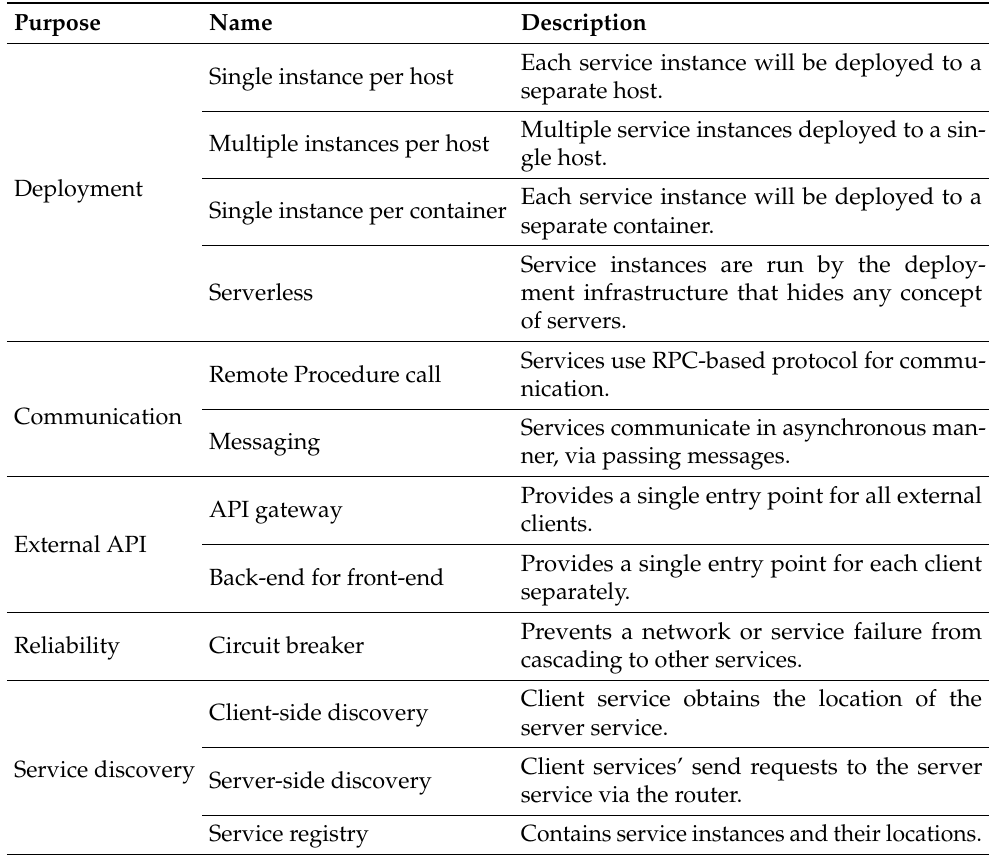
Table 2. Microservice design patterns. Descriptions of all presented designed patterns are given by Richardson